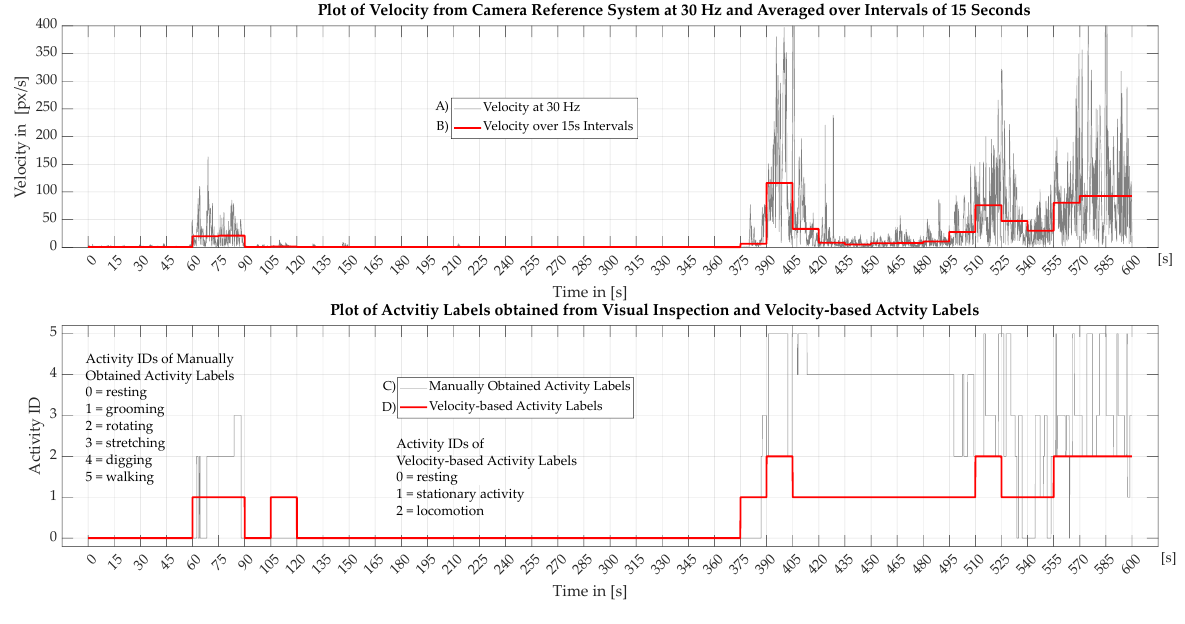
Figure 4. This figure shows two graphs with four plots containing various activity labels and the velocity of the mouse of a 10-min excerpt. The upper graph depicts the velocity of the mouse obtained from the camera reference system at 30 Hz as well as average values over intervals of 15 s. The lower graph illustrates activity labels from visual inspection of the camera images as well as velocity-based activity labels. The activity classes are depicted as activity IDs ranging from 0 to 5 for plotting purposes. The X-axis of the charts are